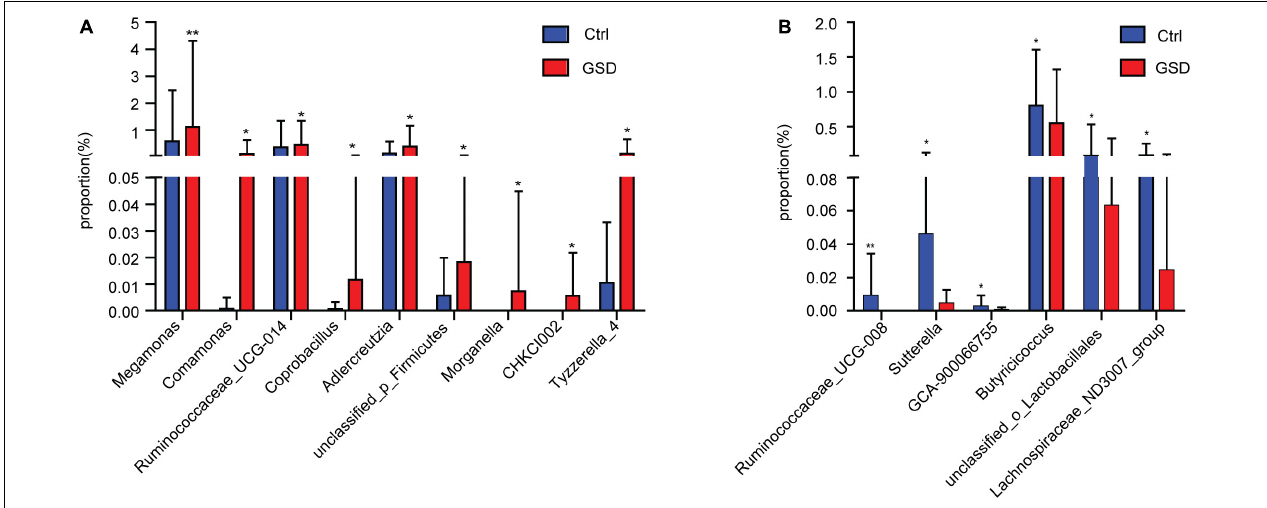
FIGURE 3 | Comparison of gut microbiota abundance between asymptomatic gallstone group and control group at the genus level. (A) Genera with increasing abundance in asymptomatic gallstone group. (B) Genera with decreasing abundance in asymptomatic gallstone group. * P < 0.05; ** P <